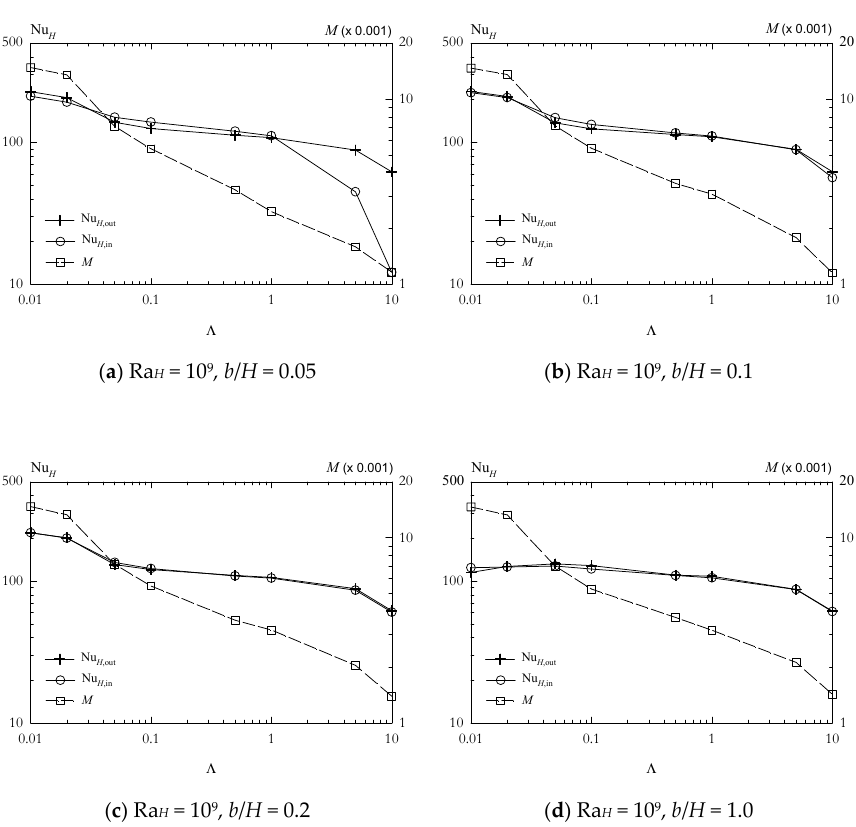
Figure 6. Influence of the thermophysical variable properties. Evolution of average Nusselt number Nu H and dimensionless mass-flow-rate M as a function of heating parameter Λ , for different values of aspect radio b / H . Configuration is given in Figure 1b. Rayleigh number Ra H = 109. Note that values of M are divided by 10 3 .